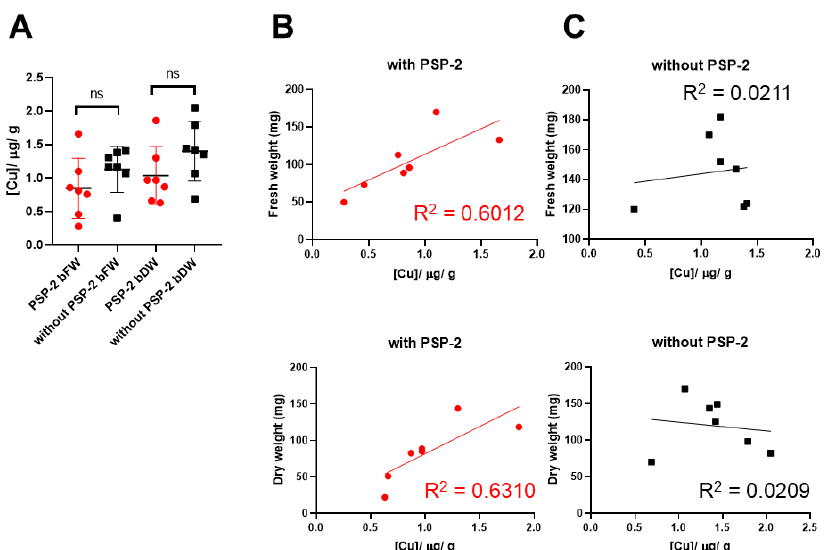
Figure 5. Copper content of H460 tumor samples ± high-dose PSP-2 based on the fresh or dry weight ( A ). Linear correlations between total copper content and fresh weight ( top ) or dry weight ( bottom ) of individual tumor samples treated either with PSP-2 ( B ) or without PSP-2 ( C ). Key: ns = not significant; bFW = based on fresh weight; bDW = based on dry weight; R 2 = correlation coefficient.